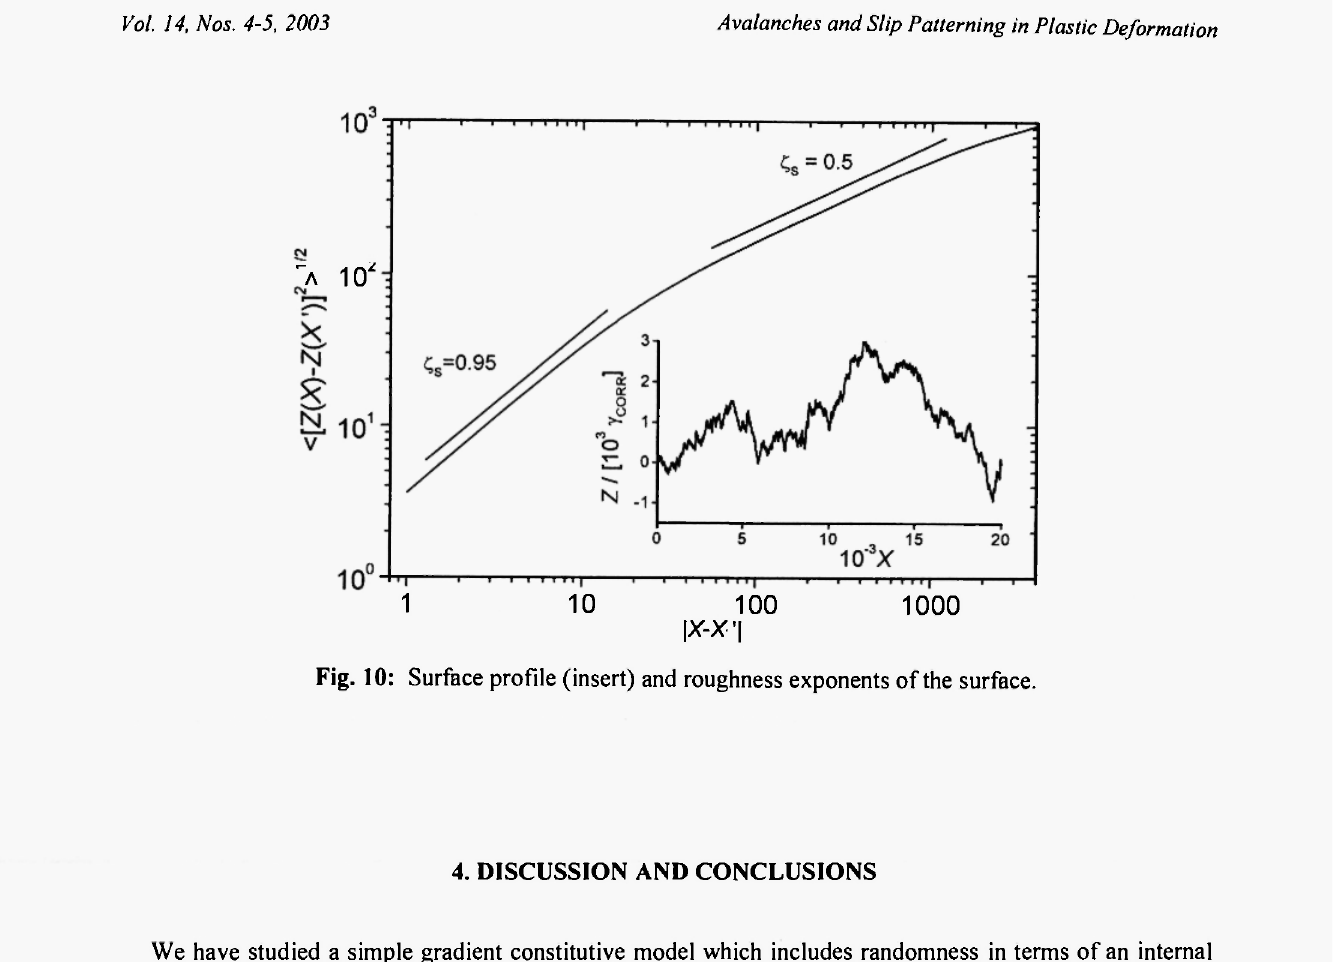
Fig. 10: Surface profile (insert) and roughness exponents of the